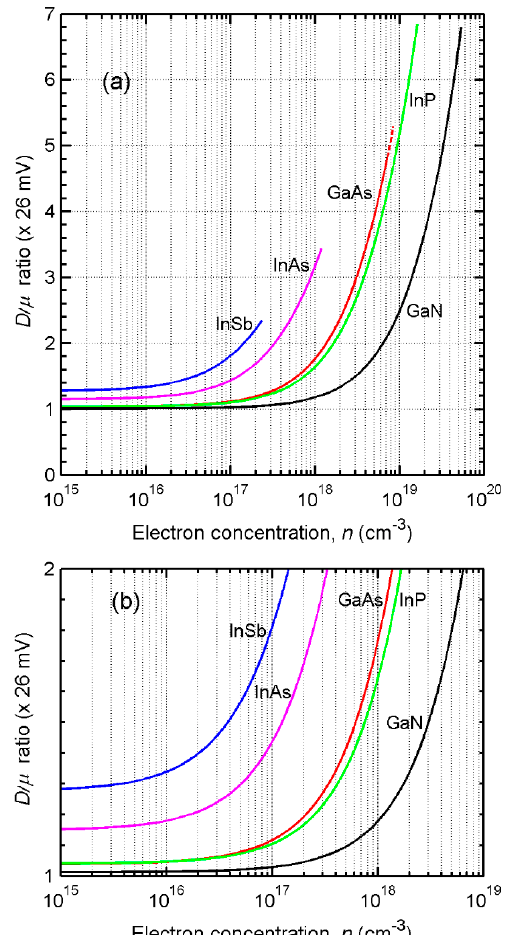
Figure 5. The same as in Figure 4, but as a function of the electron concentration. The plot ( b ) is an enlarged detailed view of the plot ( a ) for the values in the nondegenerate condition.